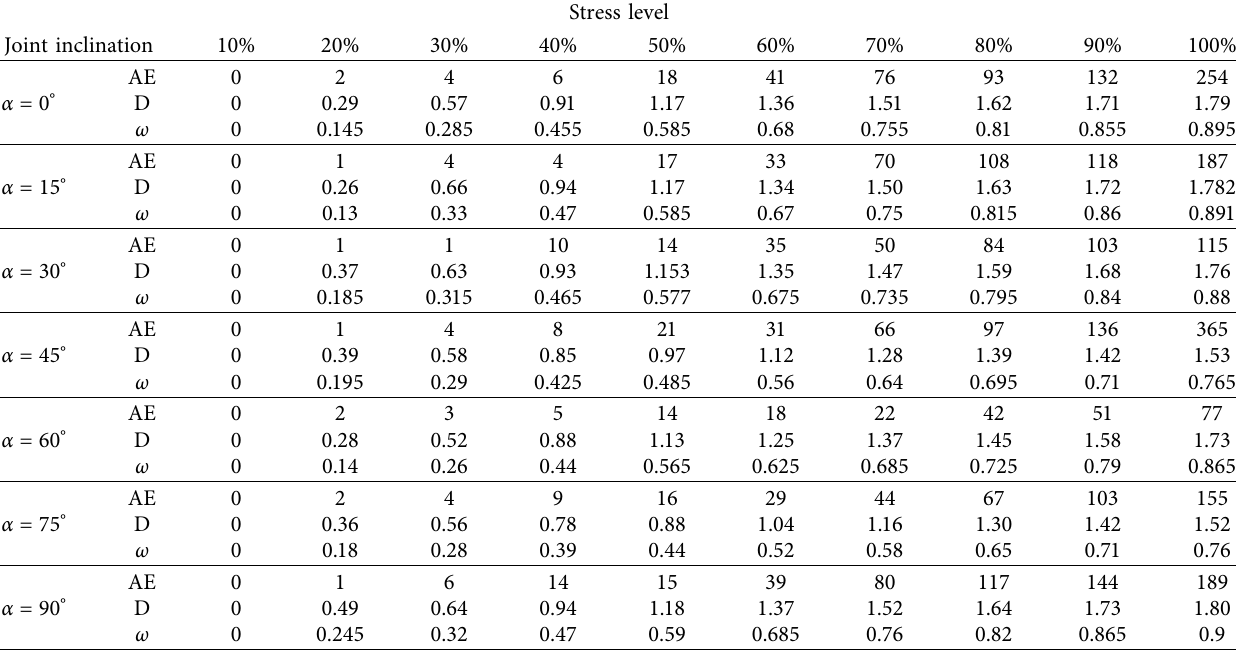
Table 4: Values of fractal dimension, damage degree, and AE energy for sandstone samples under different stress levels. Stress